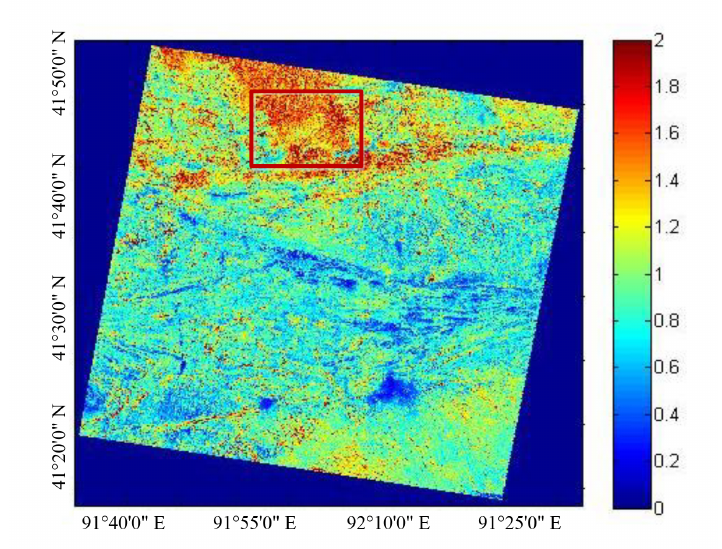
Figure 10. The reference height error caused by SNR